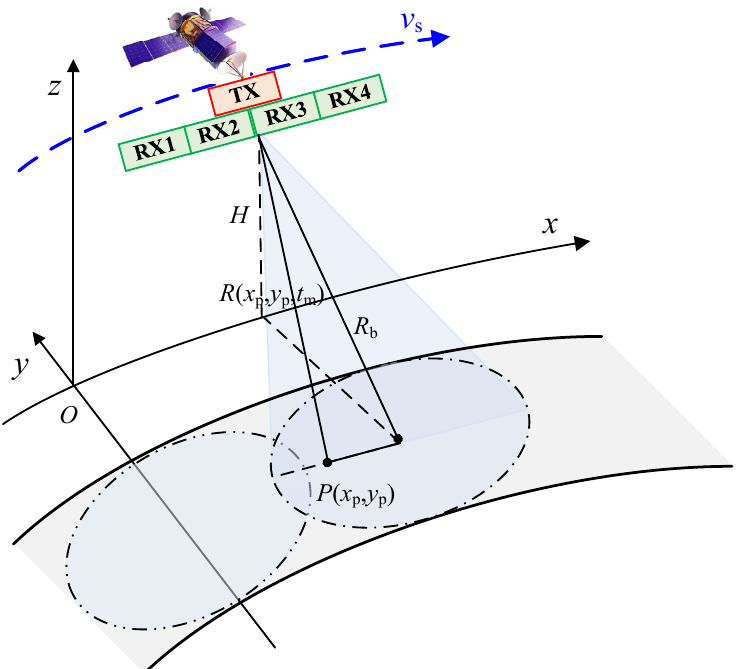
Figure 1. Geometry of azimuth multi-channel SAR.